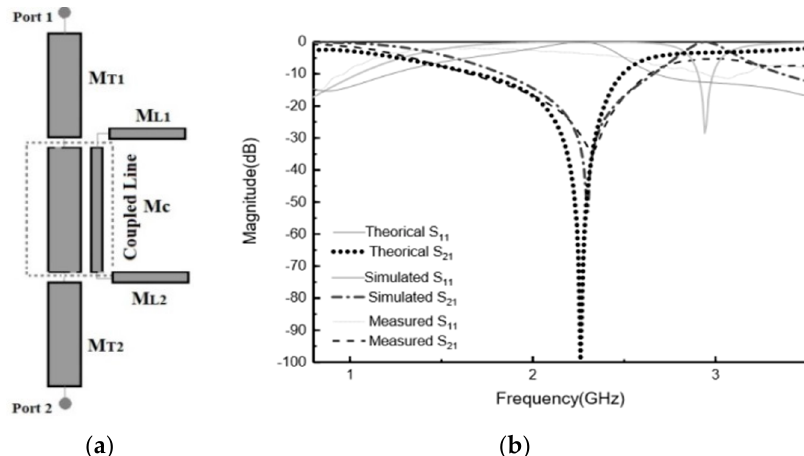
Figure 4. ( a ) Schematic of proposed model of prototype with one embroidered SRR. ( b ) S-parameter responses of the EM simulation, theoretical model, and measurement of embroidered transmission line loaded with one SRR.